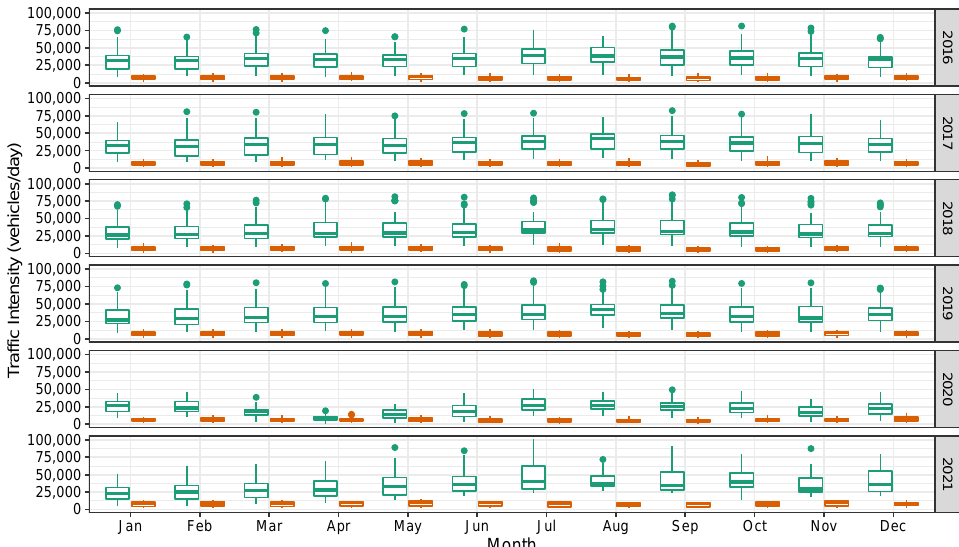
Figure 4. Box and whiskers plots of the traffic intensity (daily by day of the week) of the A-7 route in Región de Murcia. The bottom and top of the box represent the first and the third quartiles, respectively; the horizontal line in the box represents the median; dots are the outliers; whiskers are the lowest and highest values, excluding the outliers. (Source: Ministerio de Transportes, Movilidad y Agenda Urbana,